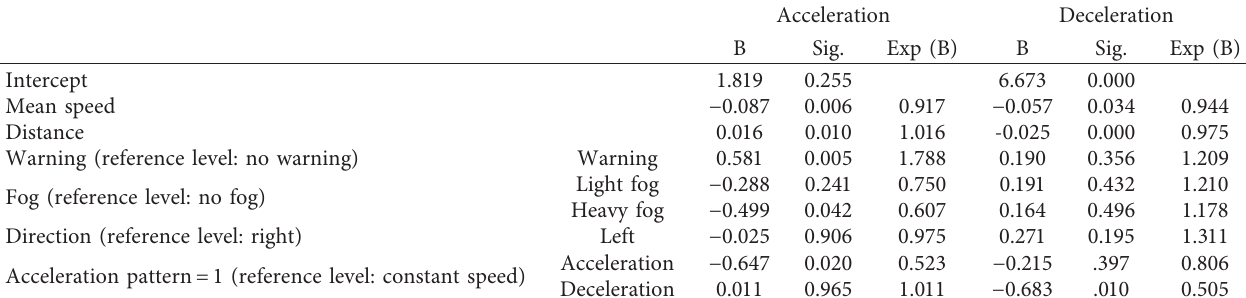
Table 3: Multinomial logit model results for